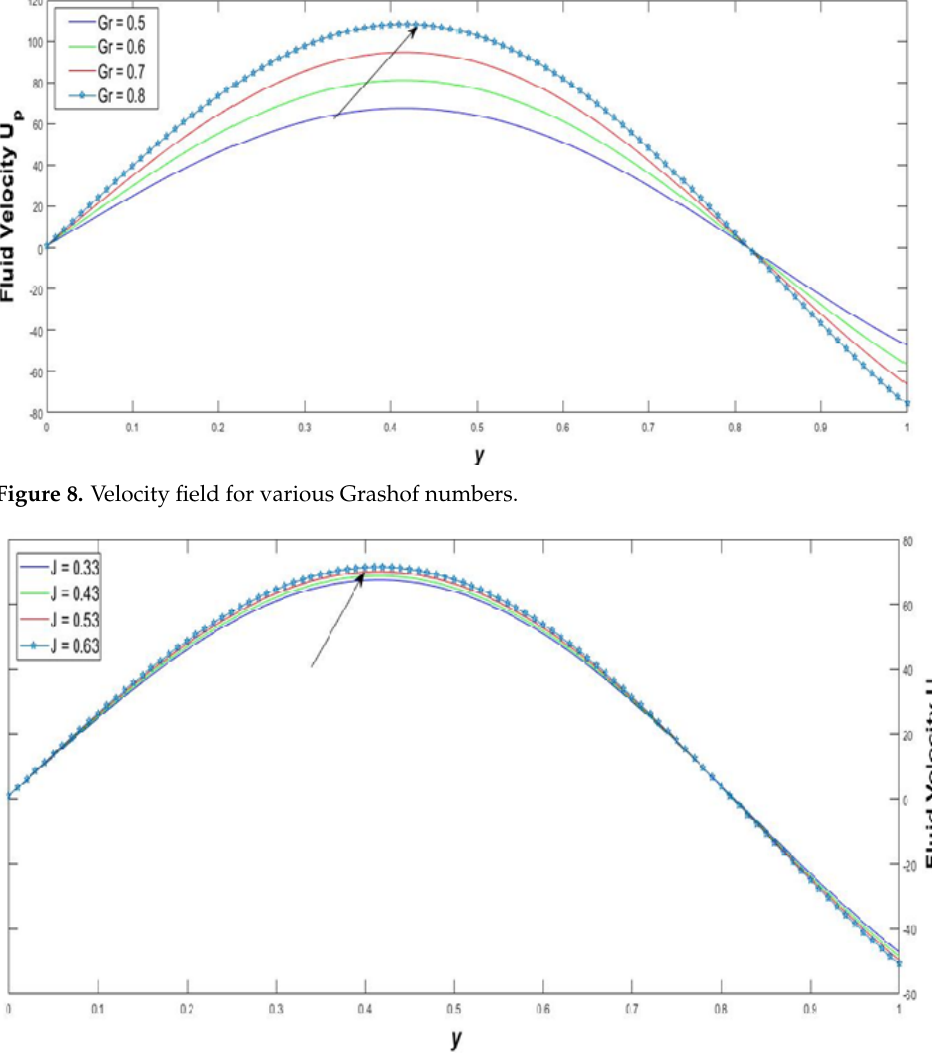
Figure 9. Velocity field for various J.